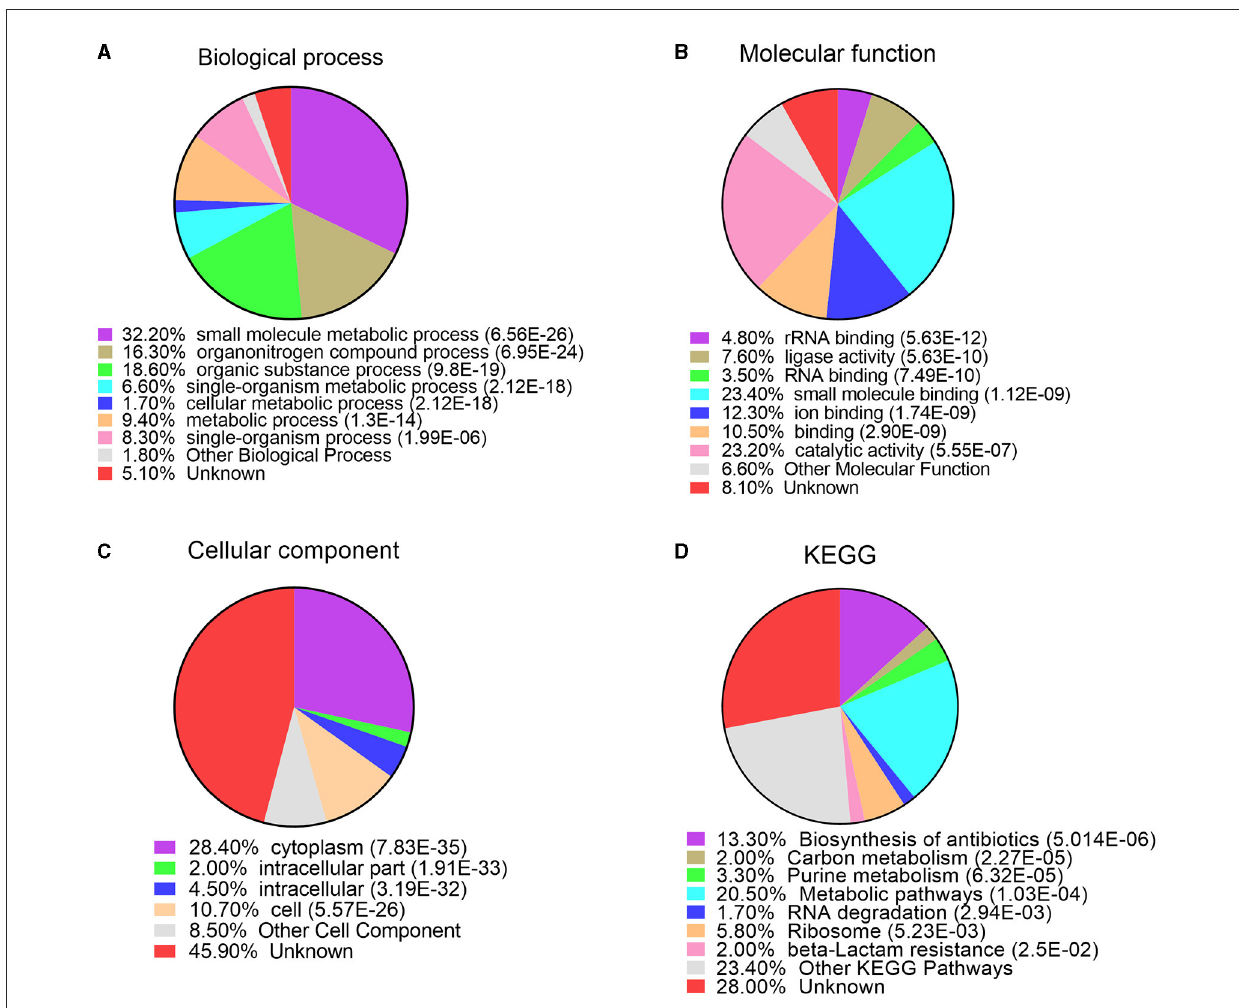
FIGURE3 GO and KEGG enrichment analysis of lysine acetylated proteins under bile salt stress in V. alginolyticus . (A) biological process, (B) molecular function, (C) cellular component, and (D) KEGG pathway.